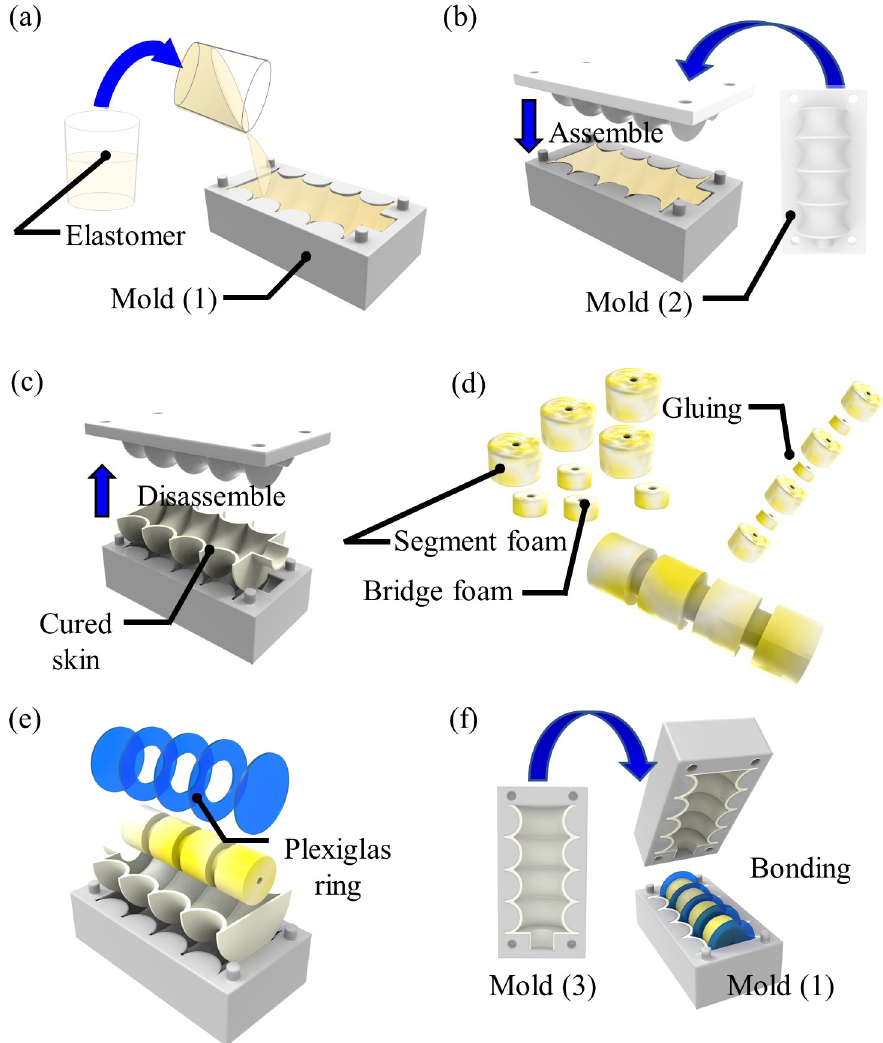
Fig 4. Fabrication procedure: For the two halves of the skin (a) pouring of specific elastomer in 3D printed mold (1); (b) mold cover (2) assembling; (c) after curing, the skin is detached from the molds; (d) foam elements are bonded using a silicone epoxy; (e) foam segments and Plexiglas © rings are integrated into one-half skin by a mold; (f) mold (3) is used to host the second half skin and for bonding with the assembled structure. Skin TM 10 or 30 part A and B were manually mixed with a weight ratio of 1:1 and degassed in a vacuum chamber. Then, the mixed liquid was poured into molds made by 3D printing (Pro- Jet MJP 3600, 3D Systems, South Carolina, US), in order to cast the two halves of the overall elastomeric skin. After curing for 15 hours, the skins were detached from the molds, as shown in Fig 4C. The foam structure was built by bonding all the elements with silicone adhesive (SIL-Poxy 1 adhesive, Smooth-On Inc., Macungie, PA, USA), as shown in Fig 4D. Since the foam absorbs silicone, all the skin parts were bonded to the foam elements by brushing the same silicone material of the skin. After curing of the silicone, both halves of the skin were bonded together, as shown in Fig 4F. Additional details for fabrication are available at our lab- oratory protocol (dx.doi.org/10.17504/protocols.io.bi8bkhsn).